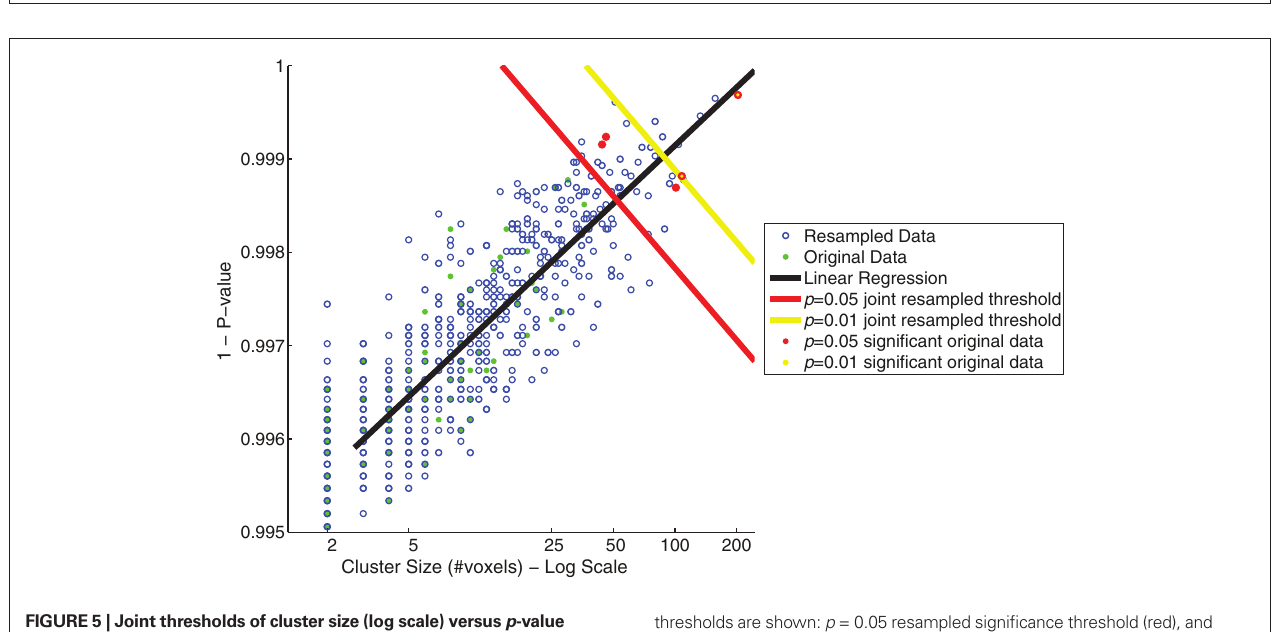
threshold (black), p = 0.05 resampled significance threshold (red), and p = 0.01 resampled significance threshold (yellow). The dashed lines of the four clusters from the original data of Goldman et al. (2009), that exceed significance thresholds are colored accordingly: three for which p < 0.05 (red) and one for which p < 0.01 (yellow).